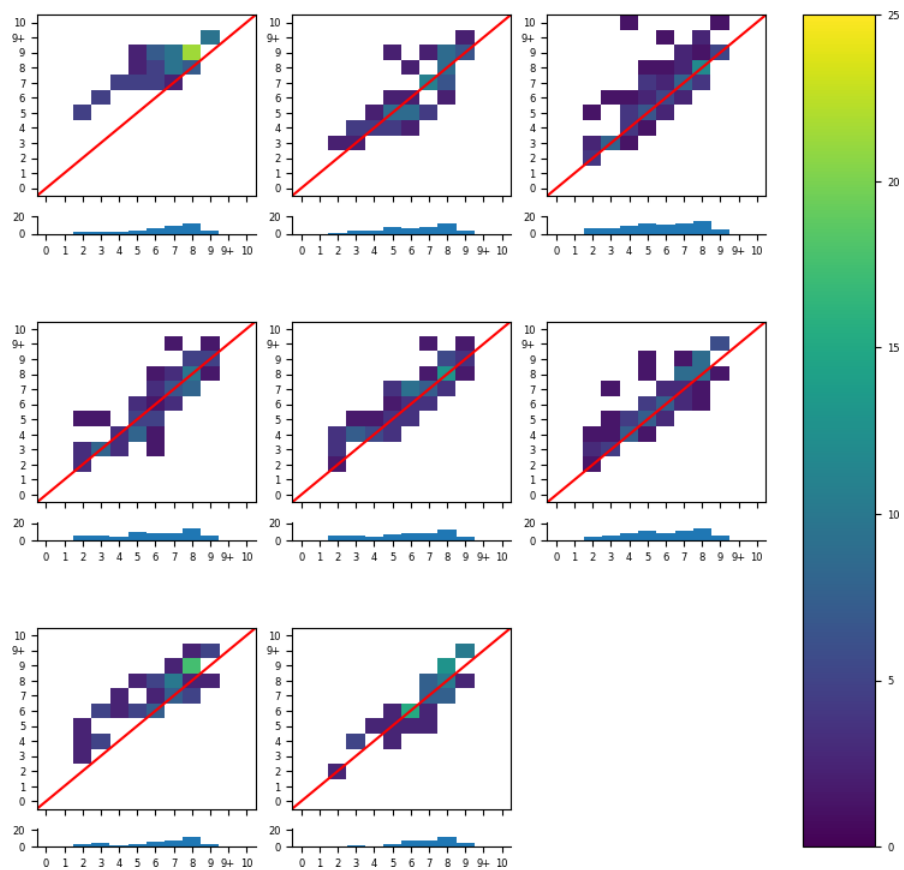
Figure 11. All eight analysts’ individual responses, reduced to only the responses where they reported the segmentation results were valid. The histogram below each contingency table shows the number of polygons in each segmentation category that they validated. The colour bar is scaled to the percentage of valid polygons.